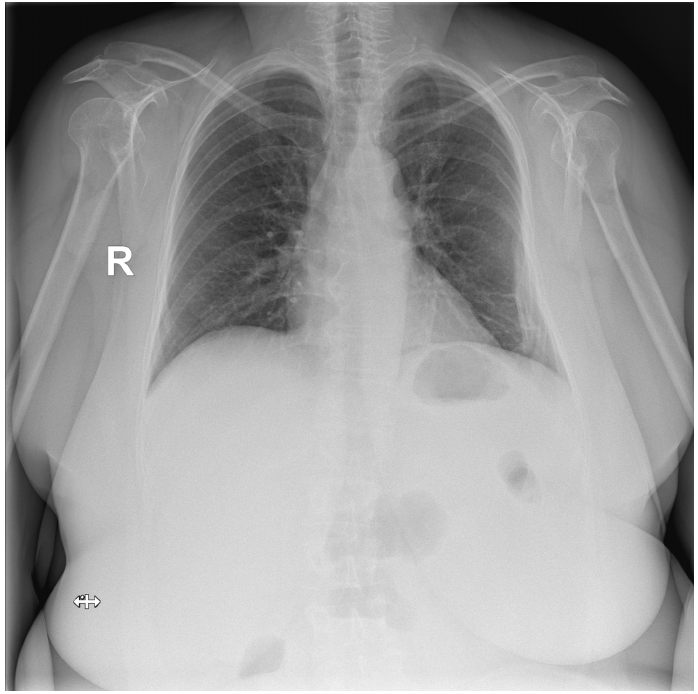
Figure A4. False Negative image #3 incorrectly classified by DLAD software during the retrospective study. The software failed to detect a rib fracture. Assessed radiologists #5f0 and #630 also incorrectly classified this image as Normal. Assessed radiologist #442 classified the image correctly as Abnormal but failed to locate a rib